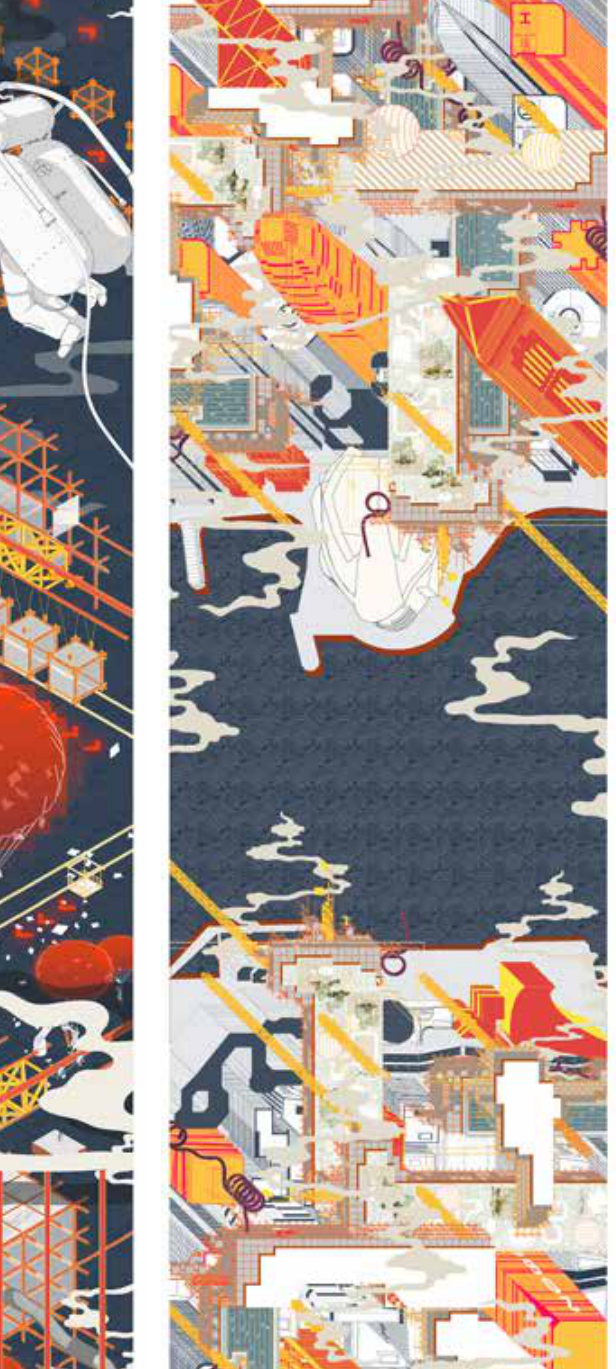
Figure 5: Chapter 5, New Region. Shows the transition towards a new Fifth Region. This highlights the large scale and infrastructural necessities through a macro- scale view showing the older city landscape of the other four regions left behind. Source: Lucas